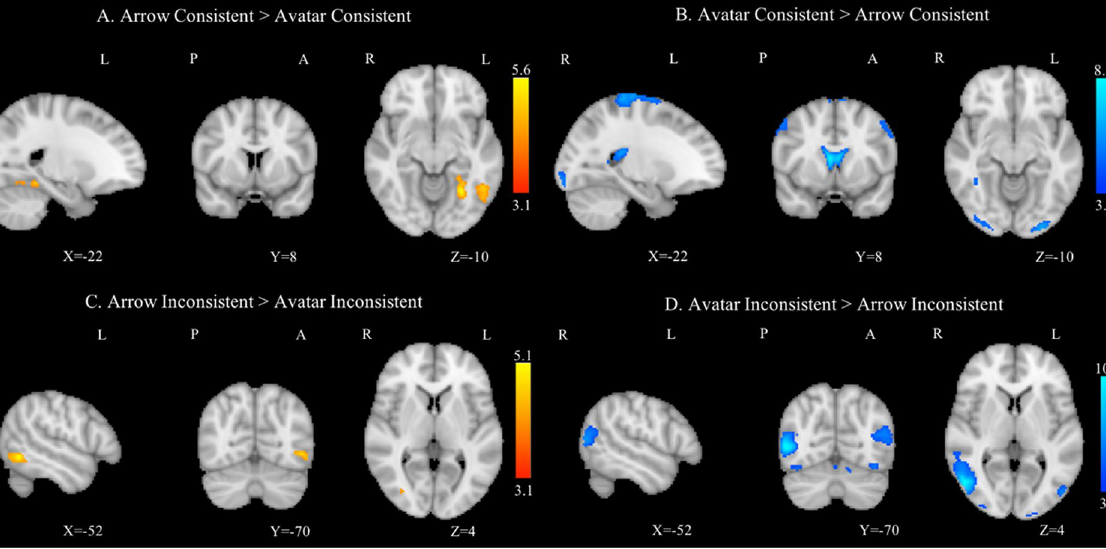
Figure 4. Group average task-related GLM analysis for the contrast Arrow Consistent > Avatar Consistent ( A ) and for the inverse comparison Avatar Consistent > Arrow Consistent ( B ), and for the contrasts Arrow Inconsistent > Avatar Inconsistent ( C ) and Avatar Inconsistent > Arrow Inconsistent ( D ). Right hemisphere on the left side, all clusters were thresholded by Z > 3.1 and a corrected cluster significance threshold of p =